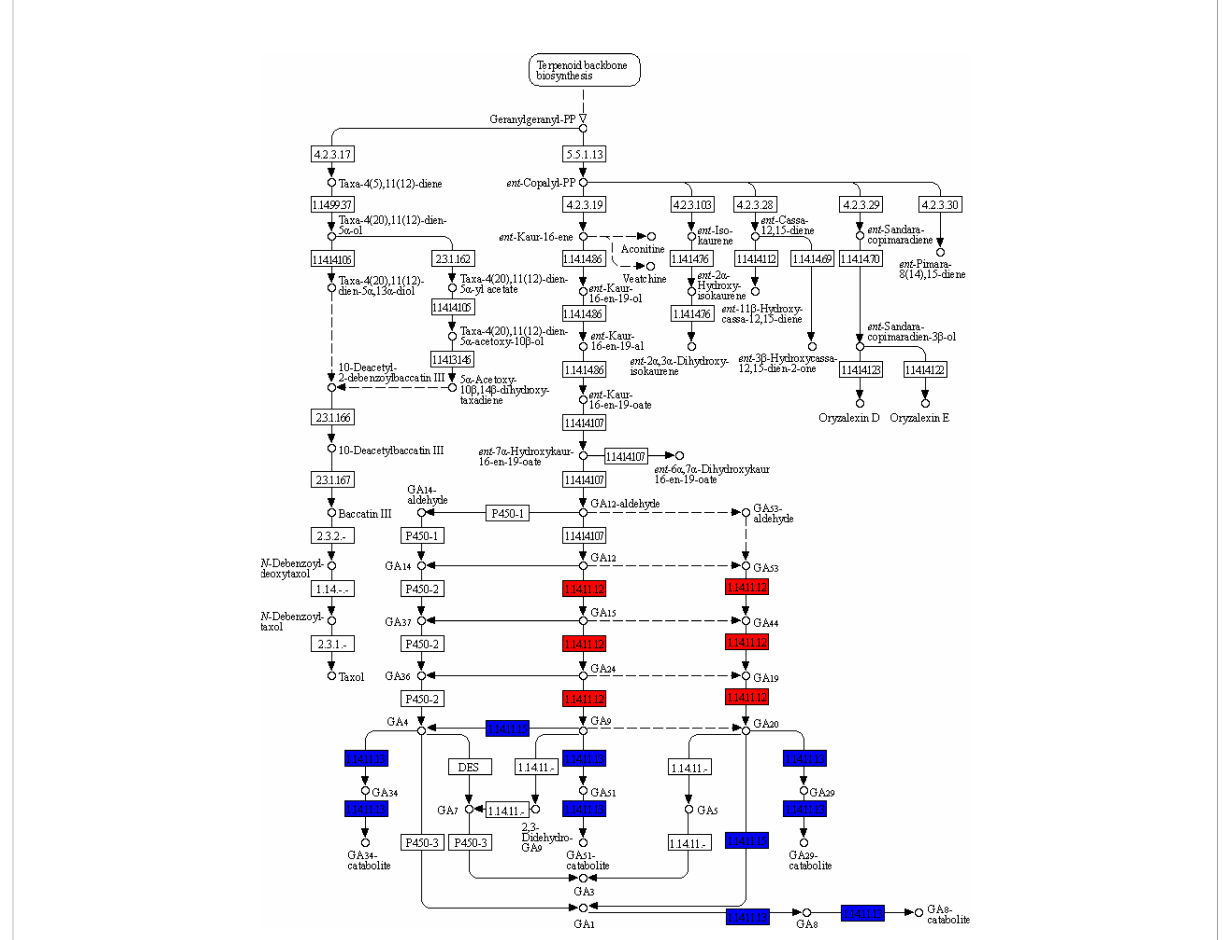
FIGURE 3 Differently expressed transcripts (DETs) of Xanthium sibiricum involved in GA biosynthesis and metabolism. Blue and red words represent that this kind of DETs were induced by ammonium and nitrate,